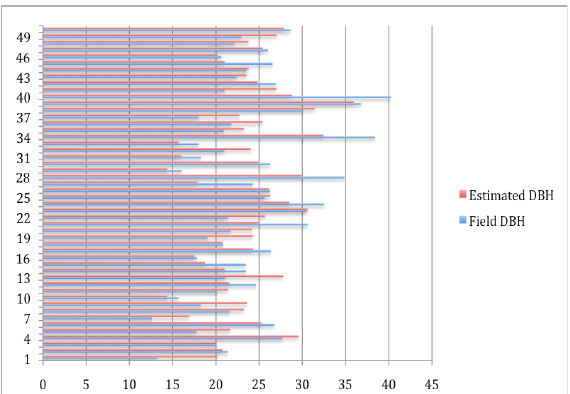
When plotted using XY scatter graph, the plot of the estimated DBH and field DBH gives an RMSE of 3.75 cm at r-squared value of 0.6 as shown in Figure 8.